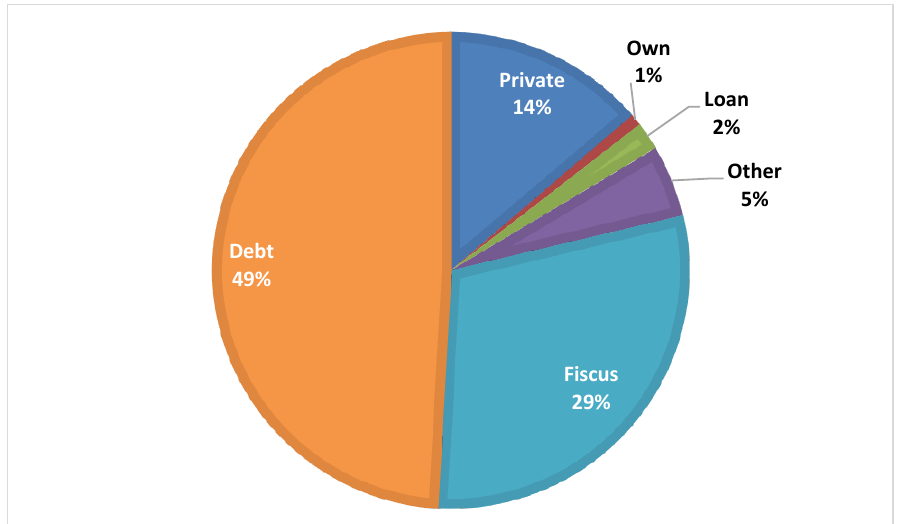
FIGURE 4: Financing of major infrastructure projects Source: National Treasury